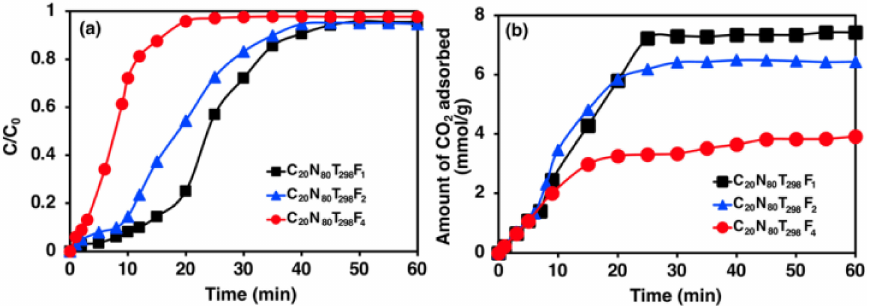
Figure 4. Effect of feed flow rate on CO 2 adsorption at 298 K, represented as: ( a ) breakthrough curves; ( b ) adsorption capacity.